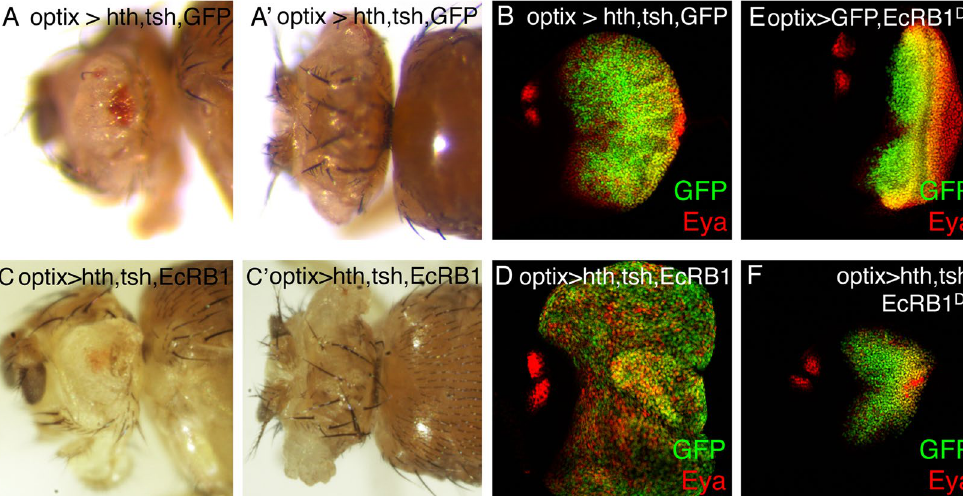
Figure 5. EcR functionally interacts with hth + tsh in inducing tissue overgrowth. Adult heads ( A , C lateral and A’ , C’ dorsal views) and eye discs ( B , D ) of optix > GFP : hth + tsh + GFP ( A , B ) and optix > GFP : hth + tsh + EcRB1 ( C , D ) (note that both genotypes harbor equal number of UAS-transgenes). Co-overexpression of EcRB1 enhances the overgrowth of lateral head cuticle and eye disc tissue. Comparison between eye discs overexpressing a dominant-negative form of the EcRB1 ( E : optix > GFP + EcRB1 - DN ) and the co- overexpression of EcRB1-DN with hth + tsh ( F : optix > GFP : hth + tsh + EcRB1 - DN ). Expression of EcRB1 causes a mild reduction in eye disc size ( E ). Coexpression of EcRB1-DN suppresses the overgrowth produced by hth + tsh (compare F with B ). Discs are stained with anti-GFP (green) and anti-Eya (red)